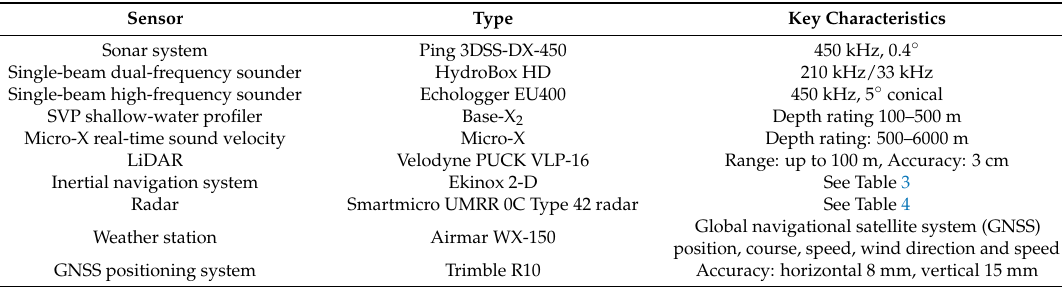
Table 2. Hydrographic and navigation equipment on the HydroDron.